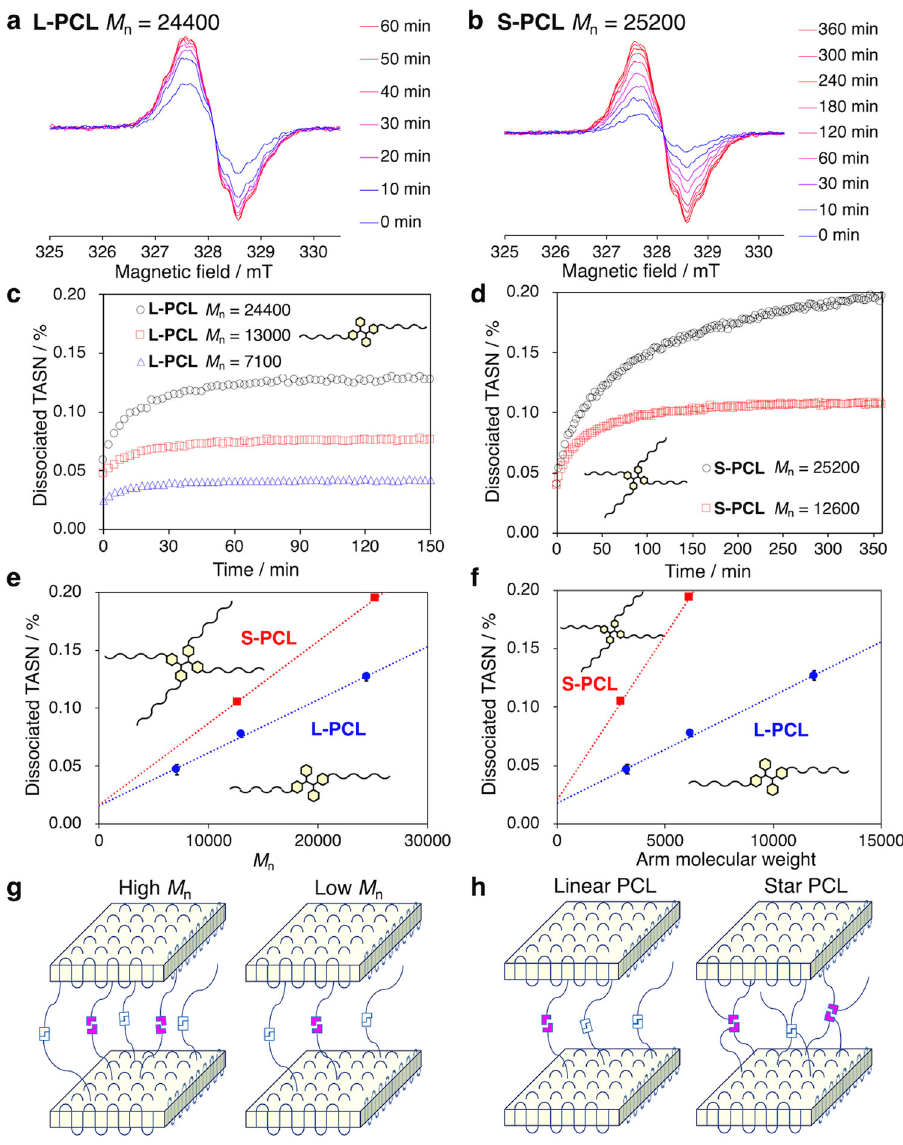
Fig. 3 Generation of radicals during isothermal crystallization. EPR spectra of ( a ) L-PCL ( M n,NMR = 24400) and ( b ) S-PCL ( M n,NMR = 25,200) during isothermal crystallization. Dissociated TASN (%) in ( c ) L-PCL ( M n,NMR = 7100: black circle, 13,000: red square, and 24,400: blue triangle) and ( d ) S-PCL ( M n,NMR = 12,600: black circle, and 25,200: red square) during isothermal crystallization. e Relationship between molecular weight and dissociated TASN (%) of L-PCL ( M n,NMR = 7100, 13,000, and 24,400; blue circle and line) and S-PCL ( M n,NMR = 12,600 and 25,200; red square and line) during isothermal crystallization. f Linear relationship between the molecular weight of the arm and dissociated TASN (%) of L-PCL ( M n,NMR = 7100, 13,000, and 24,400; blue circle and line) and S-PCL ( M n,NMR = 12,600 and 25,200; red square and line) during isothermal crystallization. Plausible schematic illustration of chain conformations of ( g ) high- and low-molecular-weight polymers and ( h ) linear and star-shaped crystalline polymers between lamellar